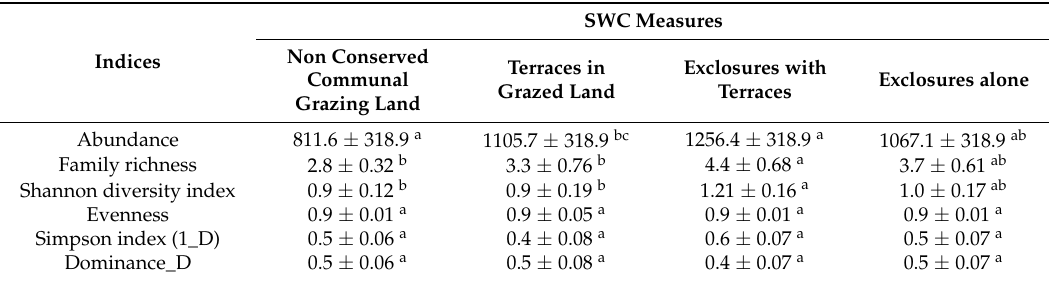
Table 4. Effect of SWC measures on abundance and diversity of soil macroinvertebrates (family level) (Mean ±